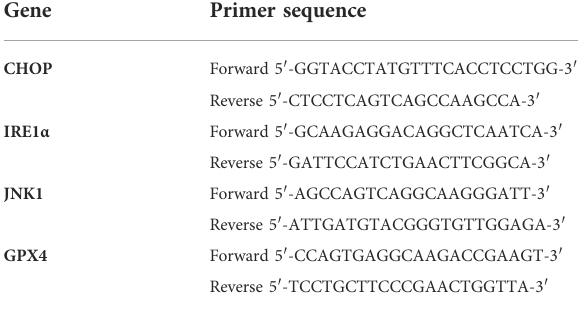
TABLE 1 Primer sequences used in this study